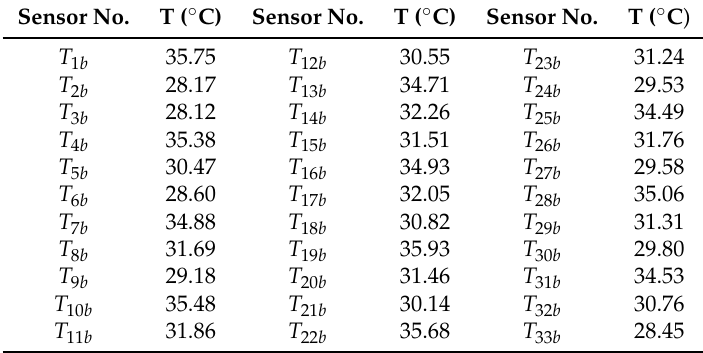
Table A1. Results of temperature measurements, 2D, natural